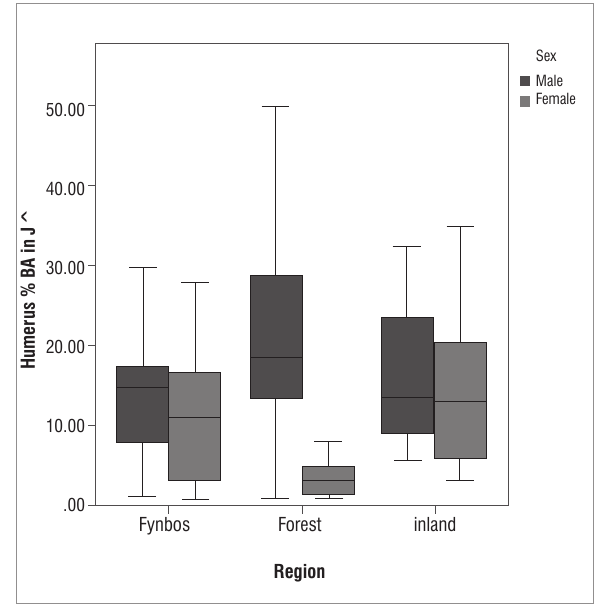
Figure 4: Comparison of humerus bilateral asymmetry (%BA, see Table 3) in torsional strength (J^) for the lower Orange River Valley (inland), fynbos and forest samples.